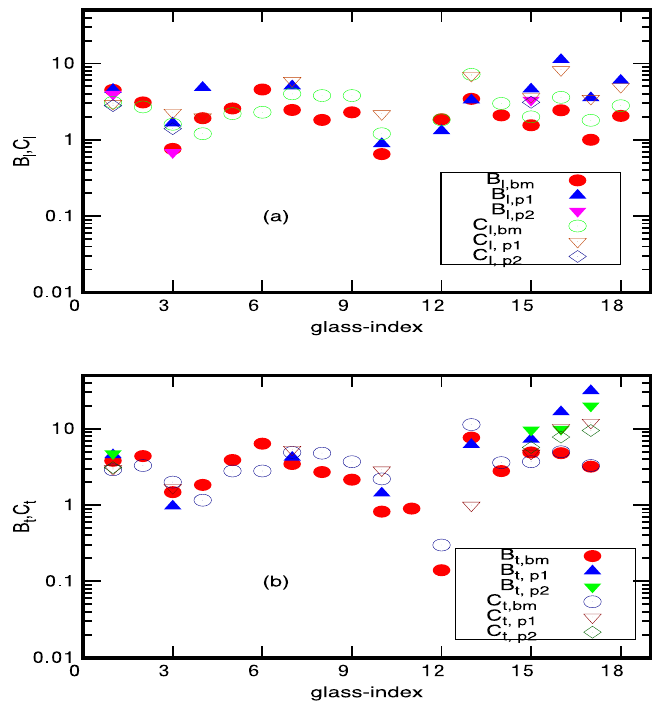
Figure 2. B a -values for 18 glasses (with M = M 1 ): The figure depicts the theoretically predicted B a and corresponding experimentally known tunneling strengths C a with respect to glass-index (all listed in Table 1). Here B a , xx refers to Eq. (47) using tunneling parameters from different experiments (with xx = bm referring to experimental data from 35 , xx = p 1 to acoustic and xx = p 2 to flexural data from 1 ). The symbols C a , xx refer to experimental data from 35 and 1 accordingly.